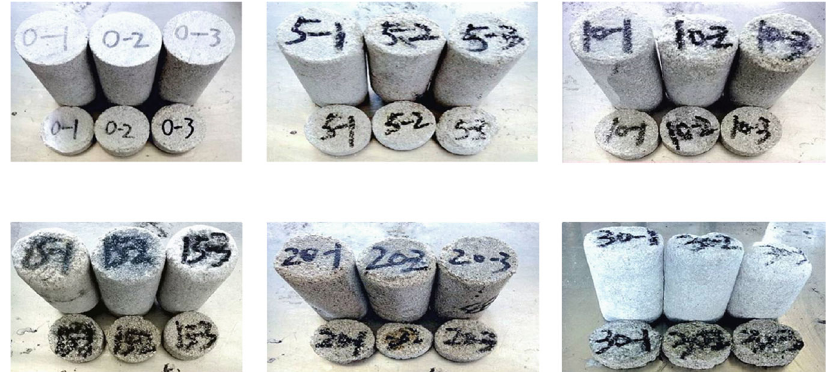
Figure 4: Characteristics of apparent erosion damage of sandstone